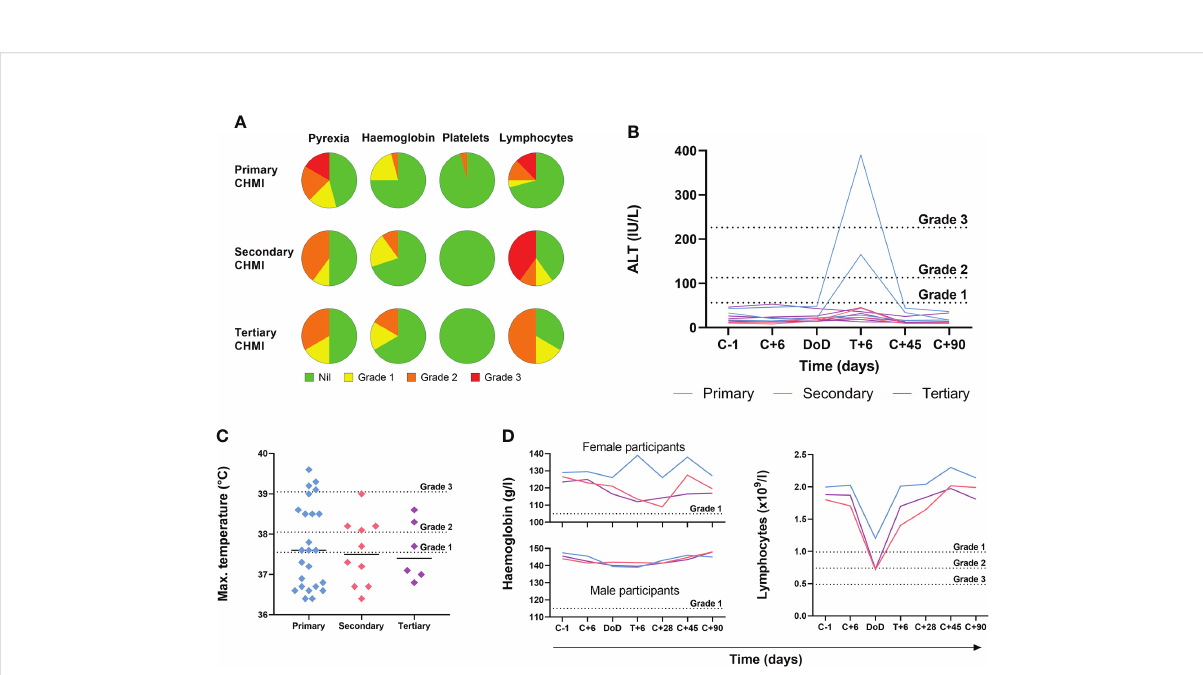
FIGURE 4 Objective measurements and laboratory AEs during repeated P. falciparum blood-stage CHMI. (A) Frequency and severity of pyrexia, anaemia, thrombocytopaenia and lymphopaenia during primary (n=24), secondary (n=10) and tertiary (n=6) CHMI from screening until 90 days post- CHMI. (B) Alanine aminotransferase (ALT) for each participant in VAC063C at each timepoint for primary (n=3), secondary (n=2) and tertiary (n=6) CHMI showing signi fi cant transaminitis after treatment of the primary infection ( P = 0.03 as calculated by Kruskal-Wallis test of peak ALT values). Dashed lines show the local cut off for Grade 1, 2 and 3 abnormalities. Time is number of days post-CHMI, except for day of diagnosis (DoD) and day 6 post-treatment (T+6) which vary by participant. The same information for VAC063 A and B (which did not include a T+6 assessment) is presented in Figure S2. (C) Maximum recorded temperature during primary (n=24), secondary (n=10) and tertiary (n=6) CHMI. Individual data points and the median are shown. Dashed lines show the local cut off for Grade 1, 2 and 3 abnormalities. Kruskal-Wallis test showed no signi fi cant difference between primary, secondary and tertiary CHMI ( P = 0.31). (D) Median haemoglobin concentration and lymphocyte count for all participants across VAC063A, B and C over time for primary (n=24), secondary (n=10) and tertiary (n=6) CHMI (of which n=18 were female and n=22 male). Time points are the same as in panel (B) Kruskal-Wallis test showed no signi fi cant difference between primary, secondary and tertiary CHMI (minimum haemoglobin concentration P = 0.93; minimum lymphocyte count P =